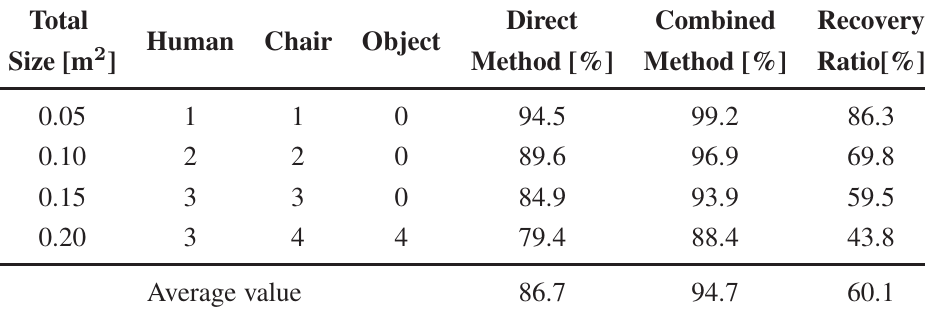
Table 2. Simulation results of measurable range and recovery